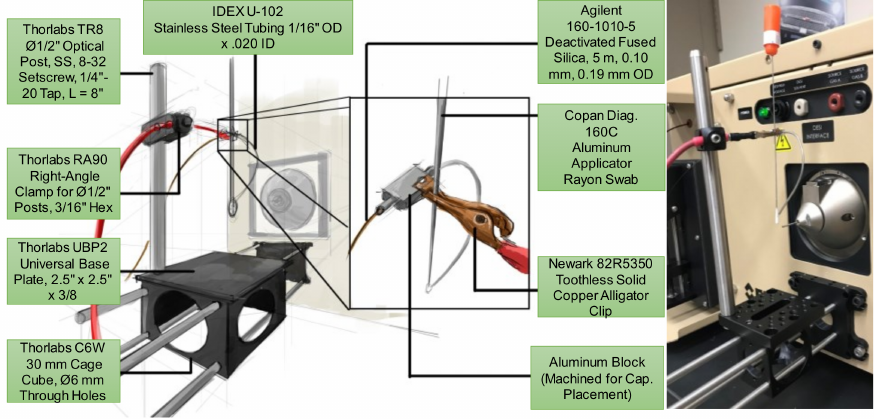
Figure 6. Simplified swab touch spray ionization (STSI) source module built upon the ThorLabs cage cube for the centralized mounting system. Similar to the PCSI source, an optical post is used to adjust positioning height of the alligator clip electrode. Depicted here is a machined clip modification, which is optional, that serves to route the fused silica, solvent delivery line running from the on-board syringe pump. A small section of stainless steel tubing, bent to an appropriate angle to maintain the position of the silica capillary in proximity to the sampling swab, is used to protect the glass-based delivery line. The high voltage applied via the alligator clip transfers directly to the wetted swab via its metallic shaft. Once adequate solvent saturates the swab, electrospray-like mechanisms produce ions from chemicals transferred to said swab during a sampling